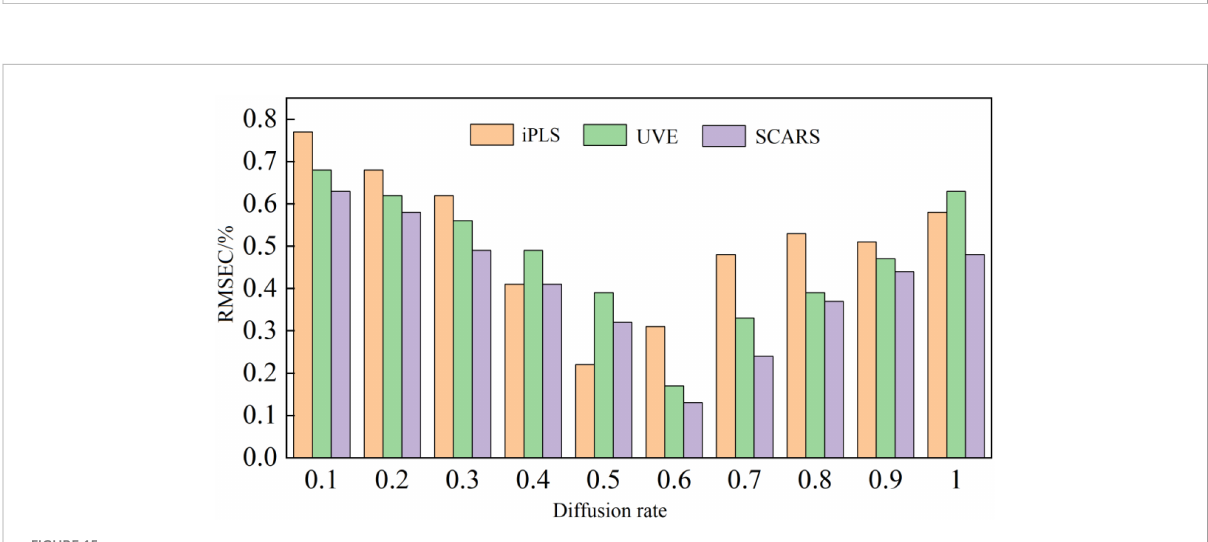
FIGURE 15 The in fl uence of the diffusion velocity on the RBFNN model.